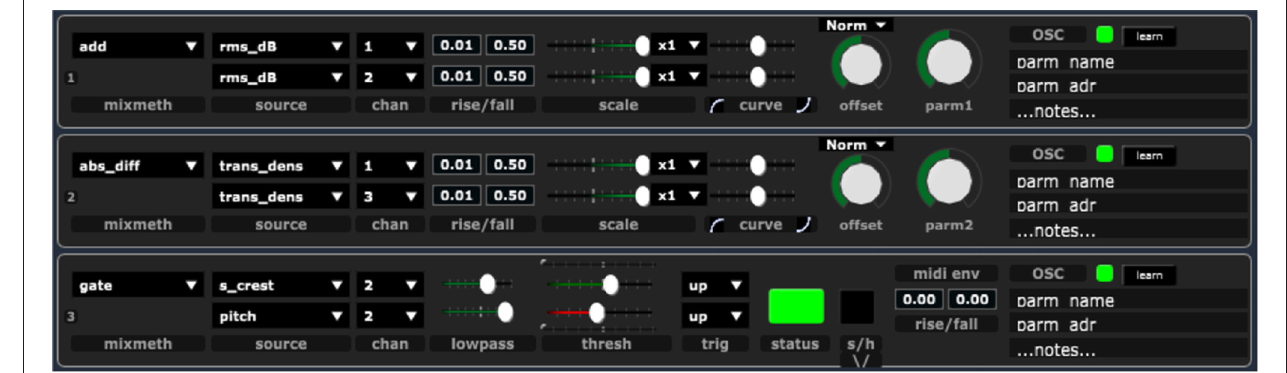
FIGURE 5 | Different modules for mapping of analysis signals from several